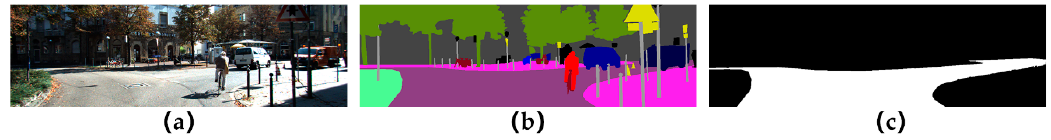
Figure 7. An example of the KITTI-occlusion-free road segmentation (KITTI-OFRS) dataset sample. ( a ) the RGB image; ( b ) annotation of semantic segmentation; ( c ) annotation of full road area, white denotes road.